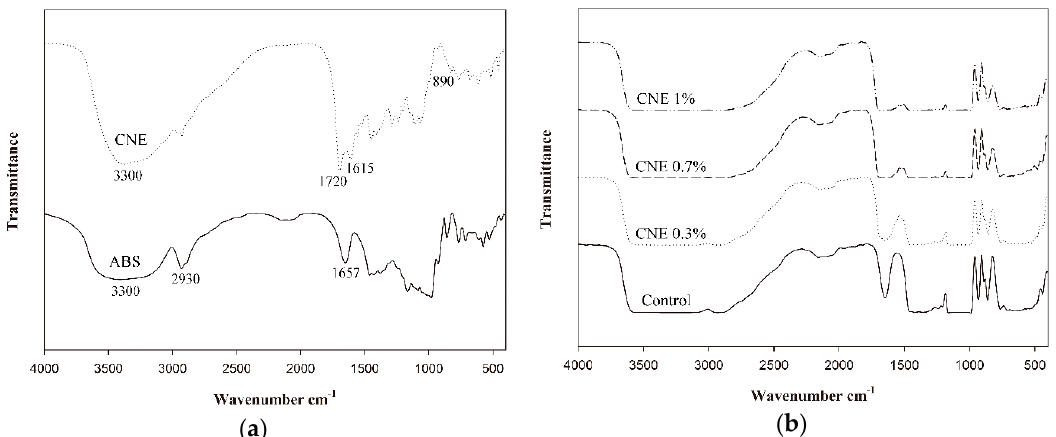
Figure 4. The attenuated total reflectance-Fourier transformation infrared (ATR-FTIR) spectra. ( a ) The components; ( b ) Adzuki bean starch films containing cocoa nibs extract.